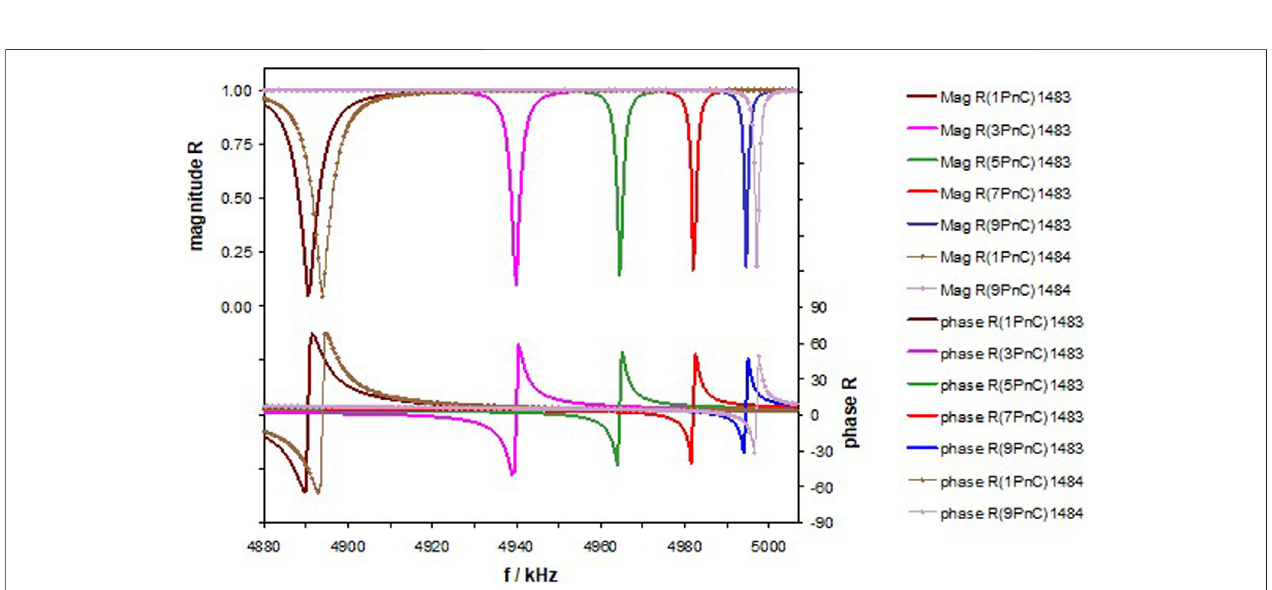
FIGURE 5 | Magnitude and phase of R at the interface between the xPnC and semi-in fi nite water. All viscosities have been considered. The sound velocity of the liquid is 1,483 m s − 1 . We further present two examples of magnitude and phase of R for 1,484 m s − 1 to demonstrate the sensor sensitivity.